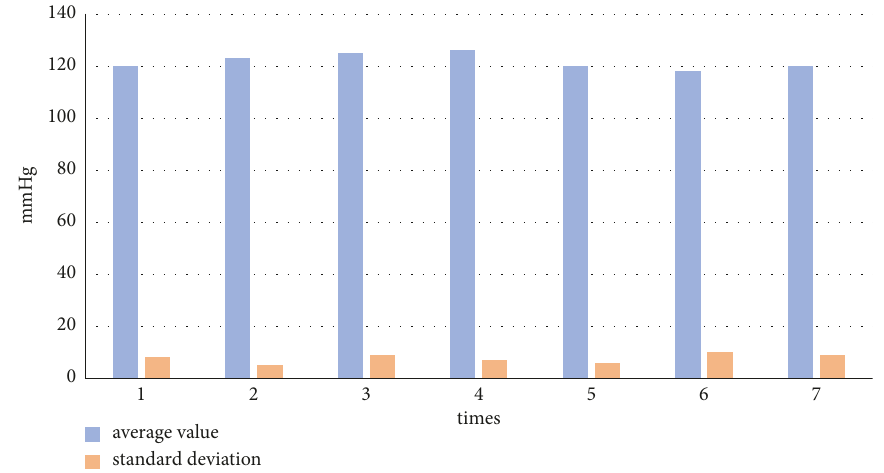
Figure 7: Trend of systolic blood pressure before training in weeks